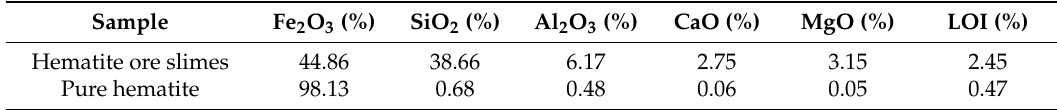
Table 1. Chemical compositions of material